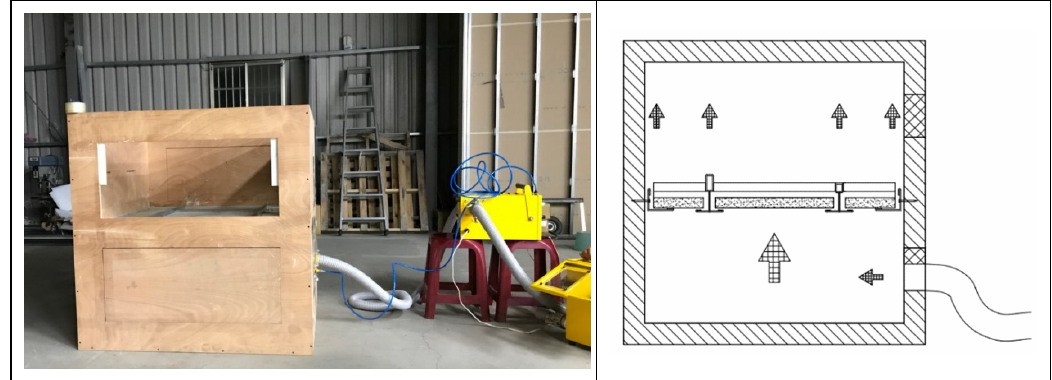
Figure 4. Schematic diagram of the smoke leakage path from the top to the bottom of the equipment in the test chamber.